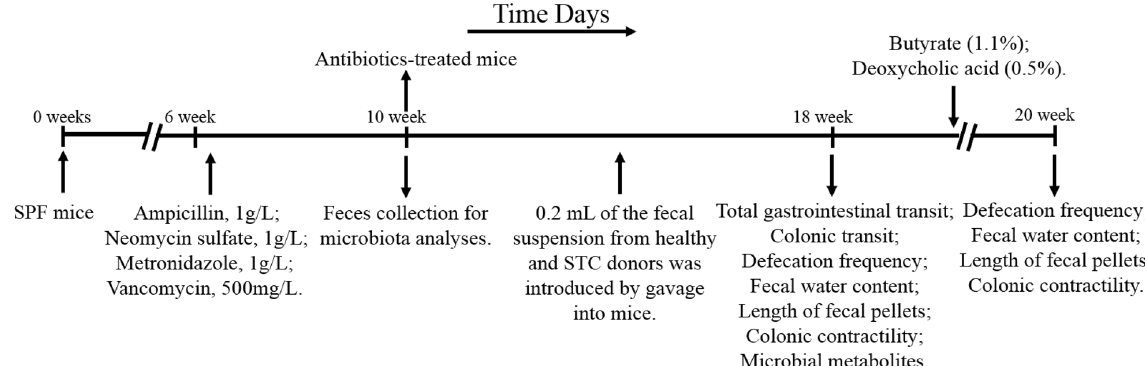
Figure 7. Experimental design indicating treatment and sampling times. STC, slow transit